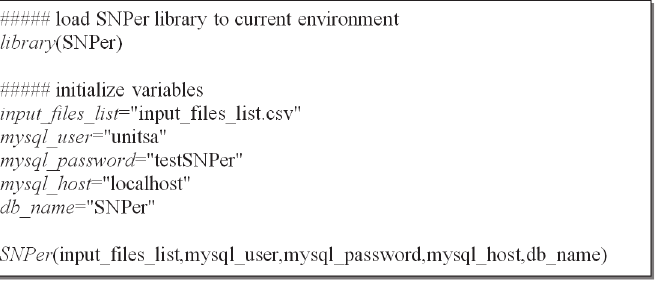
Fig 1. An example of SNPer usage. The user loads the SNPer library to current environment before using the SNPer